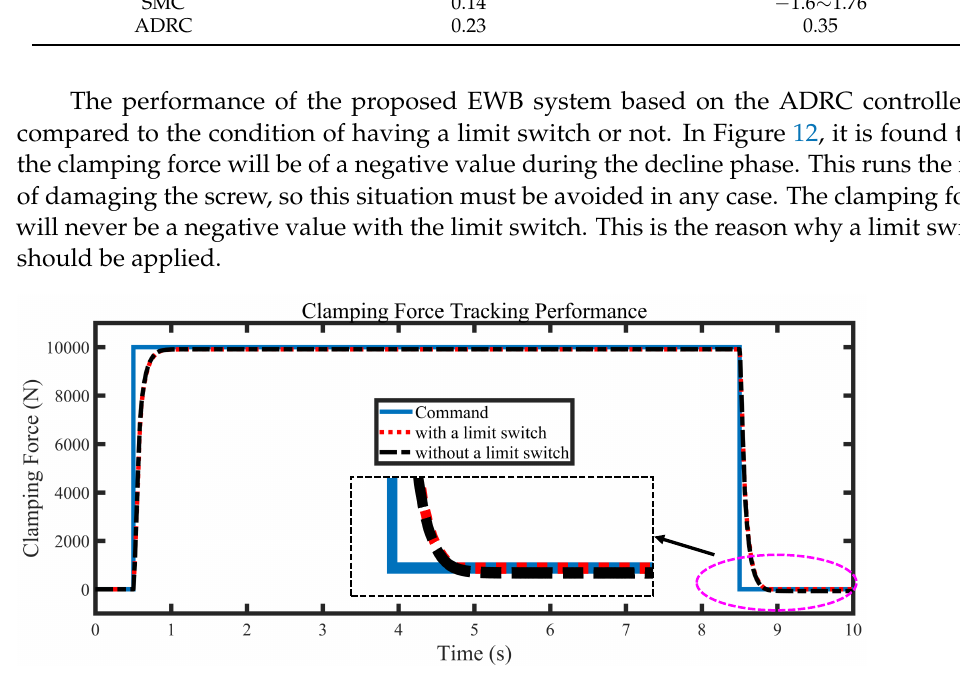
Figure 12. The performance comparison with or without a limit switch.